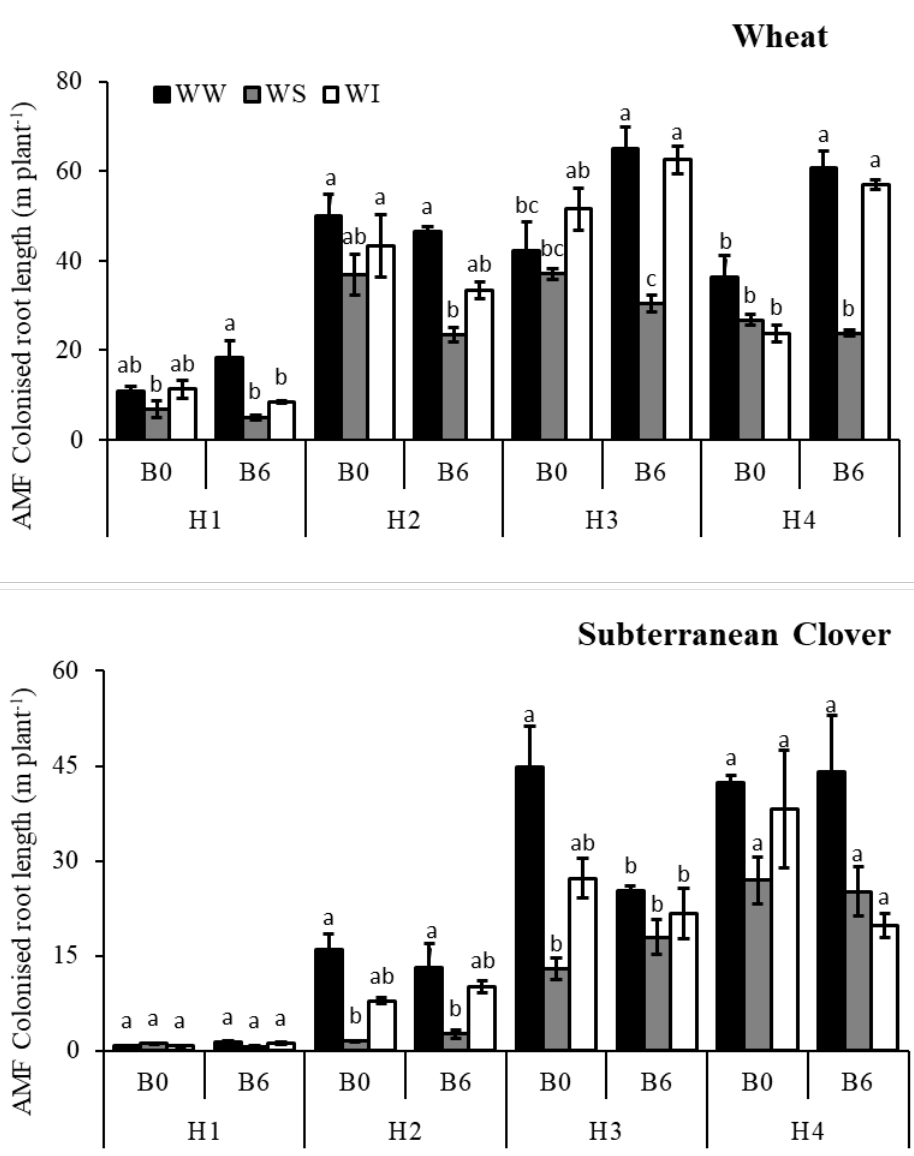
Figure 2. AM fungi colonised root length of wheat and subterranean clover for the; WW, well- watered; WS, water-stressed; WI, water intermittently at four harvest times with 6 t ha − 1 biochar (B6) or without biochar application (B0); different letters on top of bars indicate significant difference between treatments at p < 0.05 in each harvest.